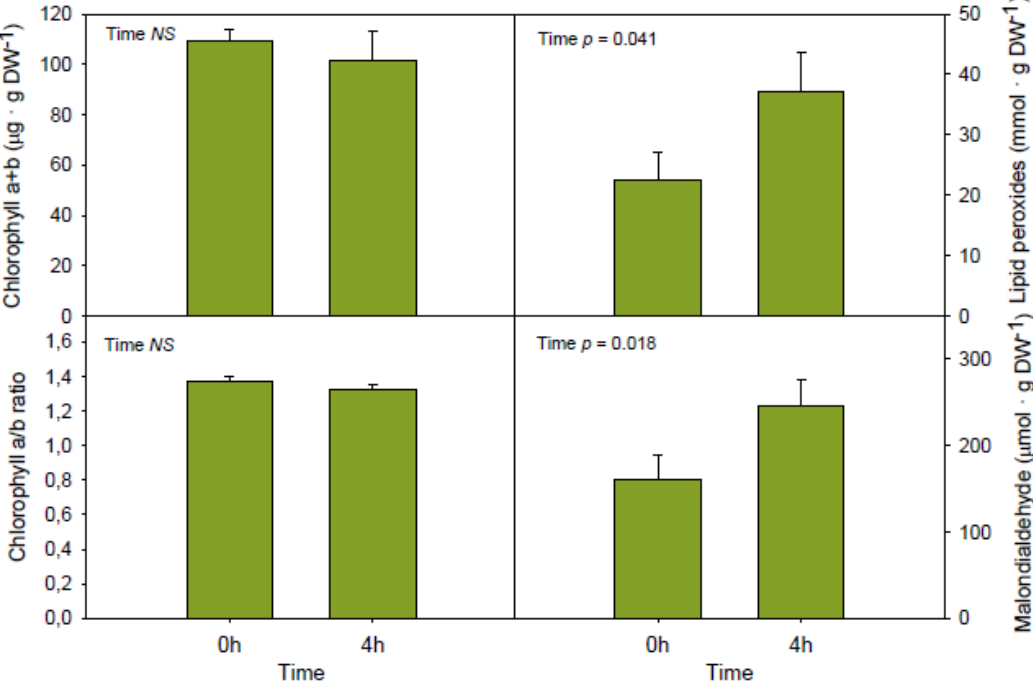
Figure 3. Influence of short-term (4 h) exposure of Bacon avocados to cold temperatures (4 ◦ C) in the contents of chlorophylls, chlorophyll a / b ratio and the extent of lipid peroxidation (estimated as the contents of lipid hydroperoxides and malondialdehyde, as indicators of primary and secondary lipid peroxidation, respectively). Data represent the mean ± SE of n = 18 fruits. Differences were considered significant when p < 0.05. DW, dry weight.